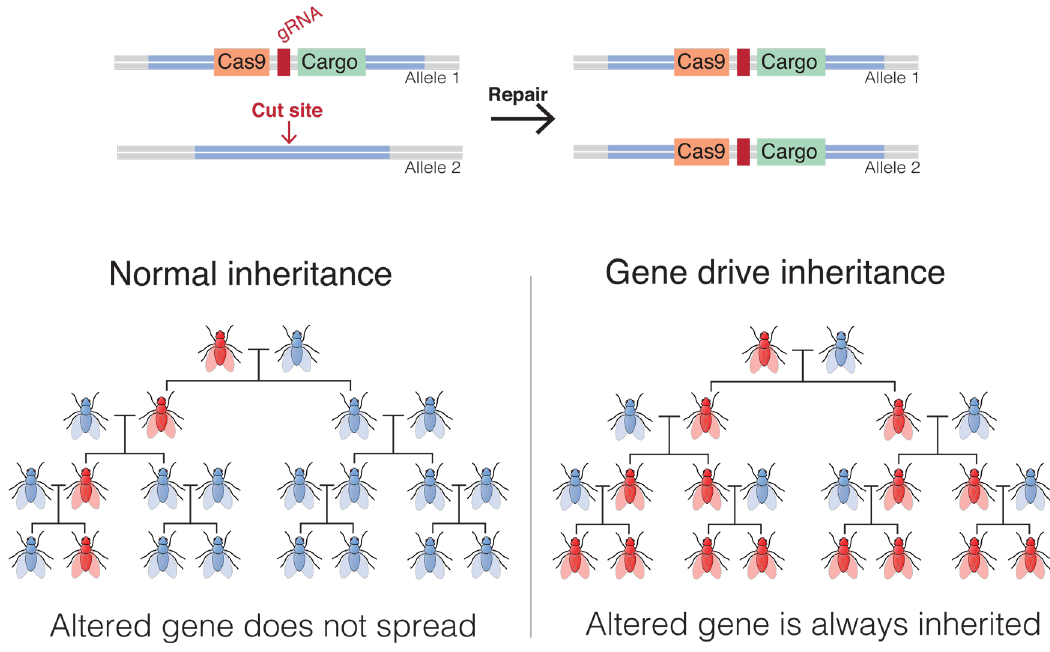
Figure 3 :Gene drive mechanism. The upper cartoon shows the conversion of a diploid cell that is heterozygous for a gene drive CRISPR/Cas9 cassette (left) into a cell that is homozygous for the gene drive cassette. The cassette encodes the Cas9 endonuclease (orange box) and the guide RNA (red box), and may contain additional coding sequences (green box labeled “Cargo”), flanked by sequences homolous to those on either side of the cut site in the unmodified chromosome. The lower cartoon contrasts the fate of a transgene in conventional inheritance (left) with the fate of a CRISPR/Cas9 targeting transgene (right). In the absence of CRISPR/Cas9 (left), a fly bearing one copy of the transgene (red) will transmit that chromosome to half of its progeny. With gene drive (right), all progeny of the fly carrying the gene drive cassette (red) will inherit a copy of that cassette. With gene drive, the transgenic flies rapidly outnumber the non-transgenic flies. Image created by